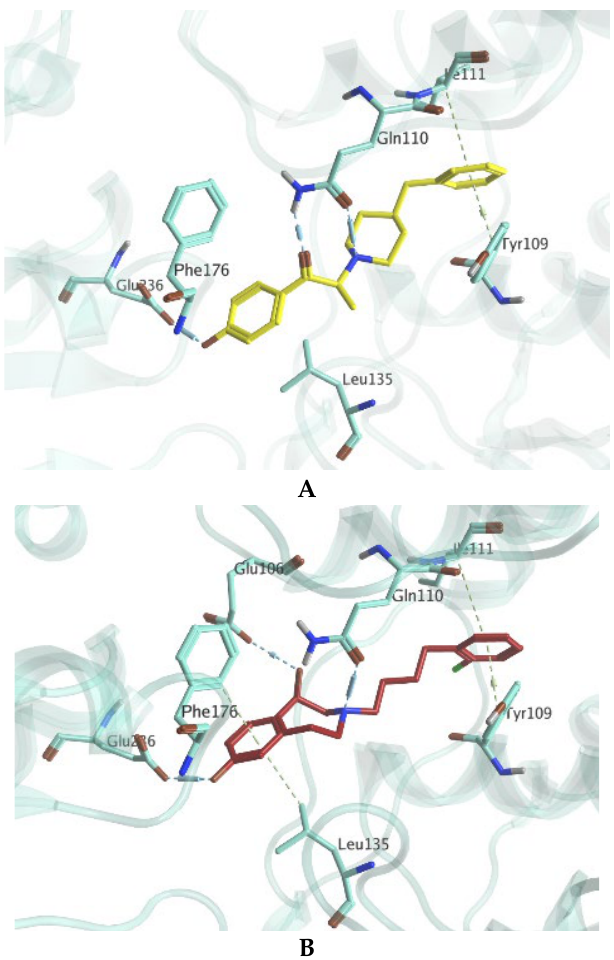
Figure 5. Predicted binding modes and possible interactions with GluN1/2B of ifenprodil ( A ) and OF-NB1 ( B ). Ifenprodil and OF-NB1 are depicted in yellow and maroon, respectively.